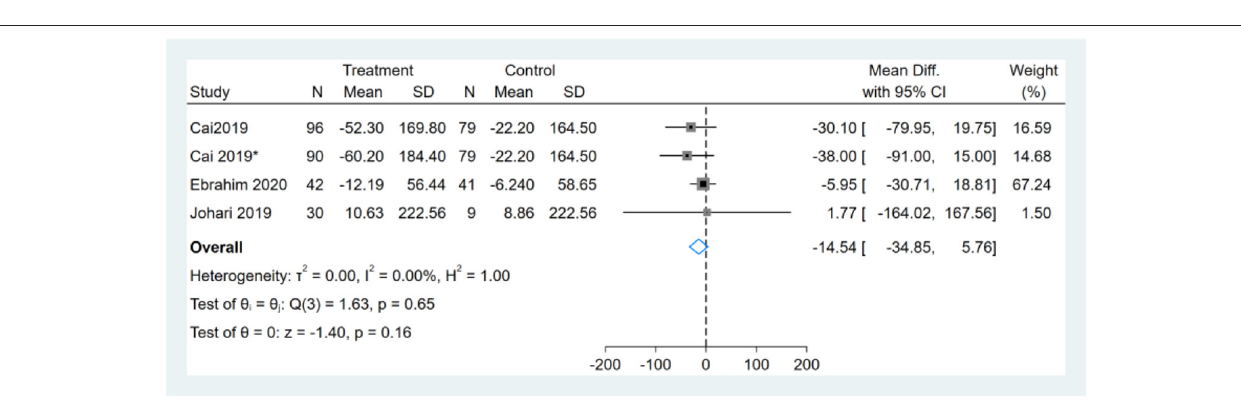
FIGURE 11 | Forest plot analysis showing changes in triglyceride (TG). *This study has two fasting intervention groups.